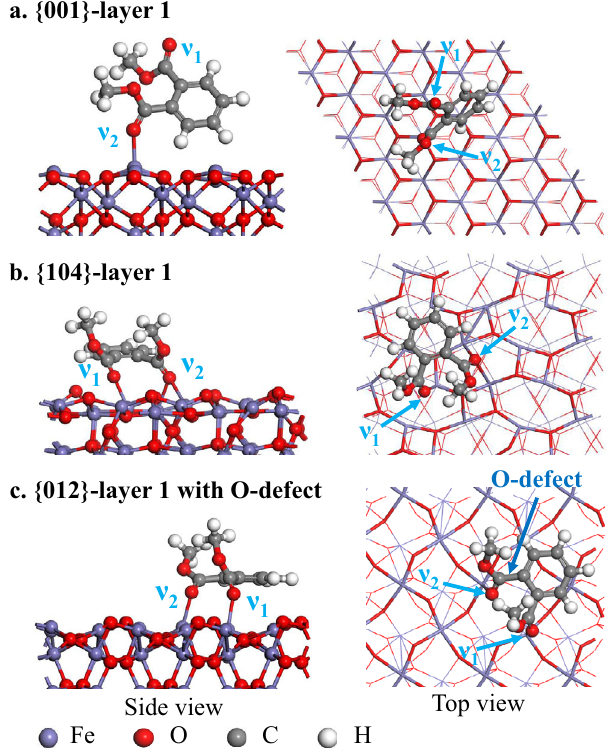
Fig.4|Surfaceadsorptioncon fi gurations. Themonodentatecoordinationmode of dimethyl phthalate (DMP) on the slab model of {001}-layer 1 ( a ); the biden- tate coordination modes of DMP on the slabs of {104}-layer 1 ( b ), and {012}-layer 1 with O-defects ( c